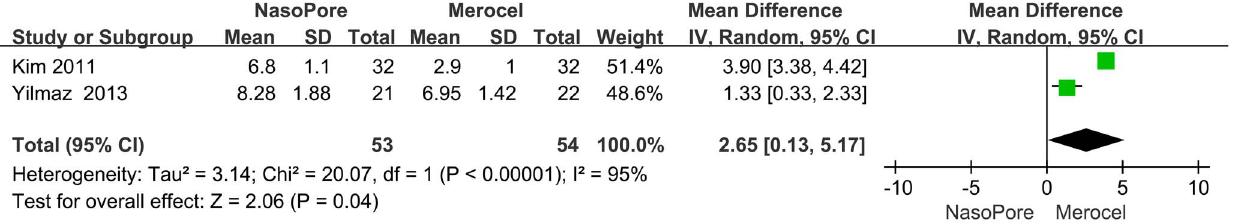
Figure 9. Forest plots of MD and 95% CI for general satisfaction.